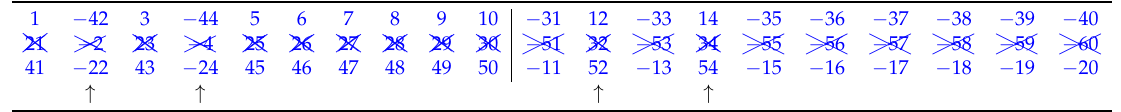
Figure 17. Single phase winding with double chording, 2nd order double-sided imbrication for N = 60, p = 1, m = 1 and q = 30. ( a ) Star of slots and ( b ) winding scheme. Table 22. WDT with a double chording and a 3-rd order double-sided imbrication for N = 60, p = 1, m = 1 and q = 30.